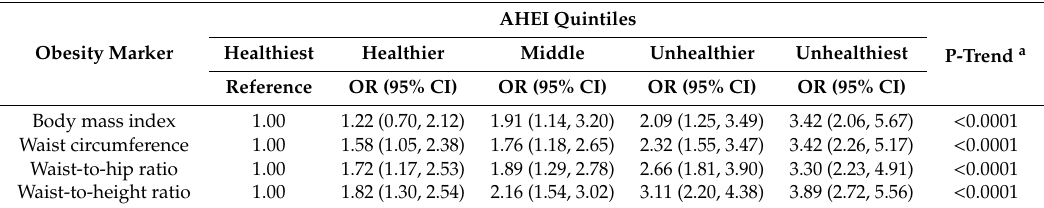
Table 3. Association between quintiles of the Alternate Healthy Eating Index and obesity markers, menuCH, Switzerland, 2014–2015.